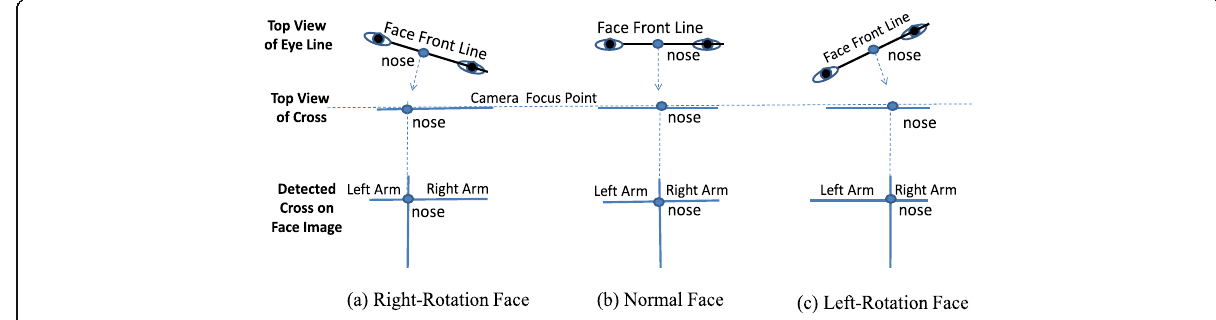
Fig. 10 Top view and detected cross lines related to the nose point of a right-rotation, b normal, and c left-rotation faces